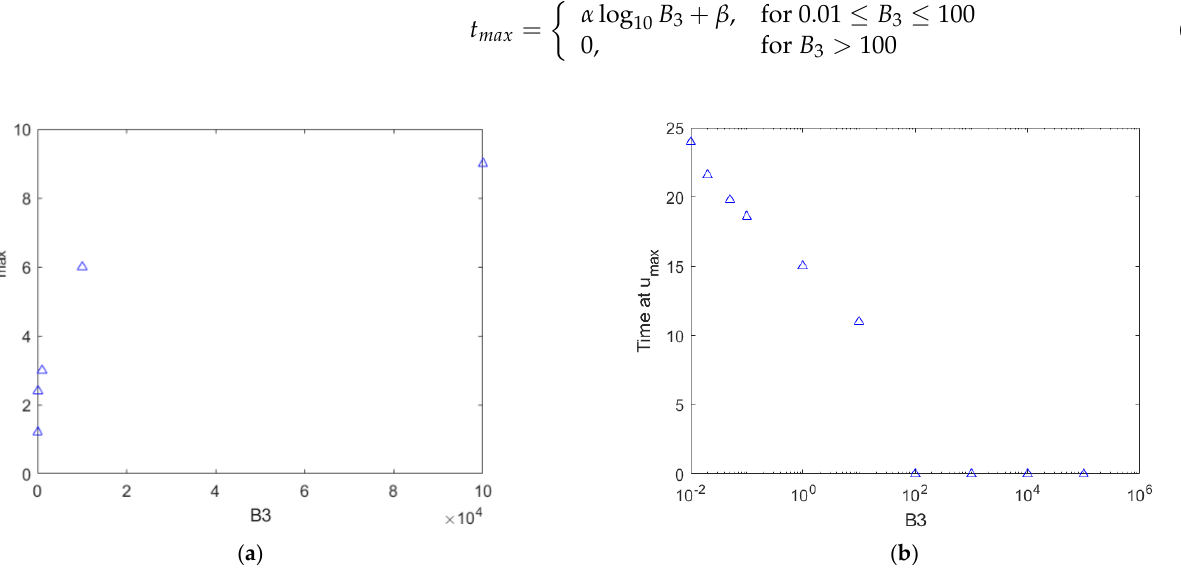
Figure 21. The t max times required for both control efforts in the application of Policy 3, for the change of B 3 weightings of Equation (27). ( a ) Control effort u 1 ; ( b ) Control effort u 2